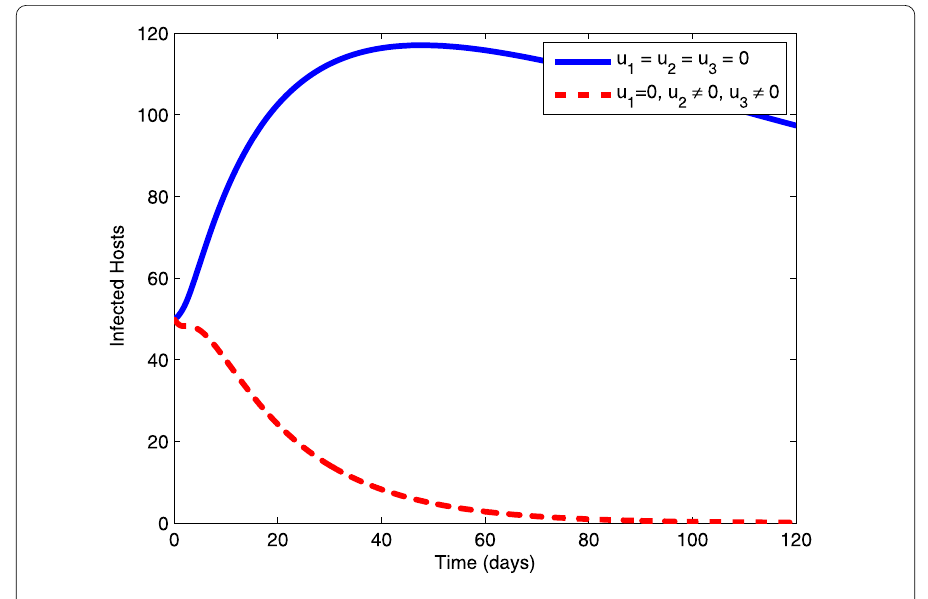
Figure 9 Infected Hosts with and without control.